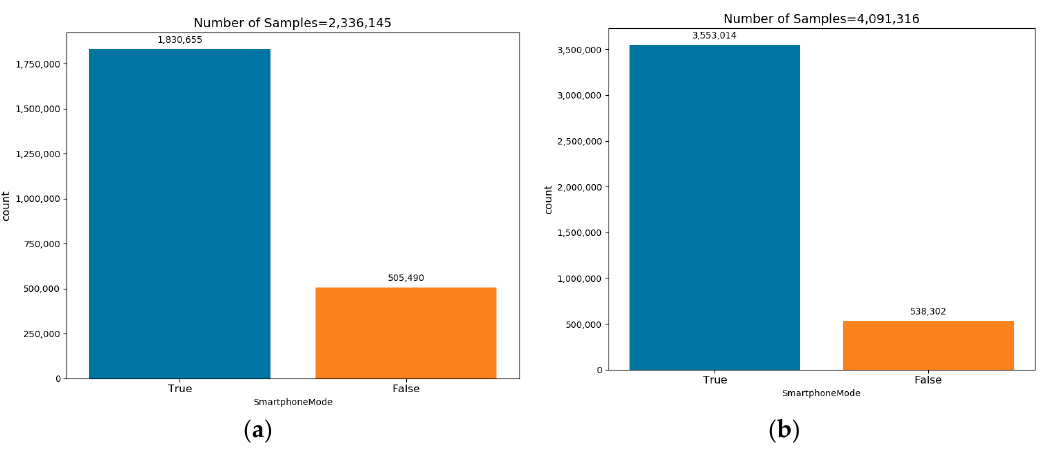
Figure 11. Train ( a ) and test ( b ) datasets’ sample distributions used for the binary classifier.